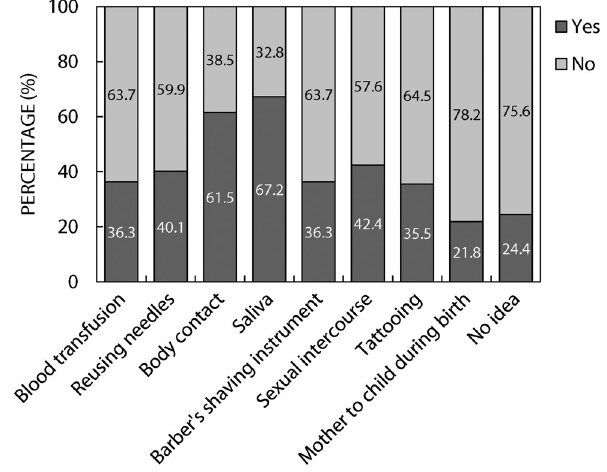
Figure 1: Knowledge of the modes of transmission of HBV.